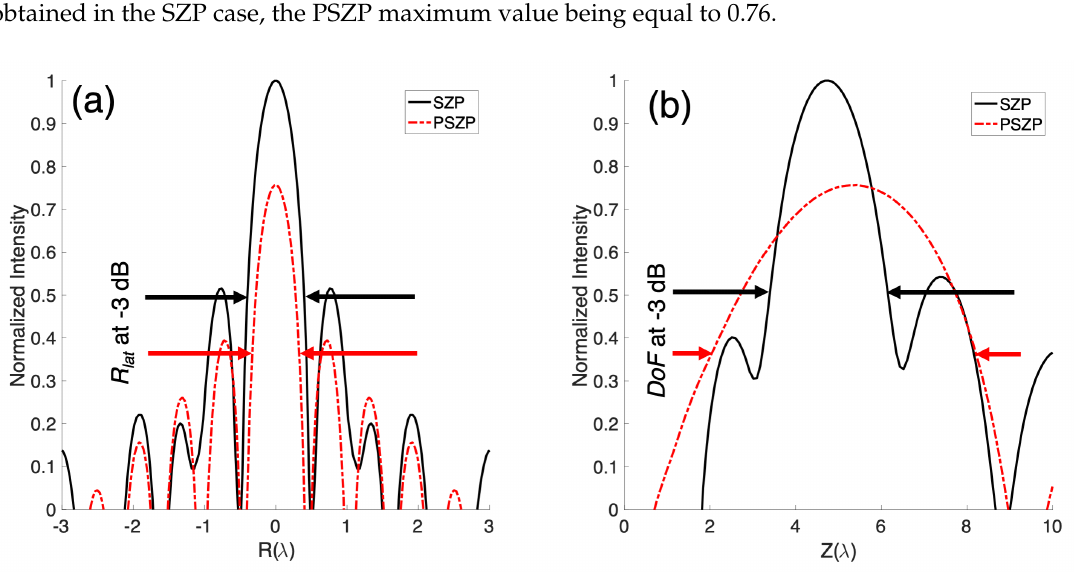
Figure 2. Numerical normalized intensity results for ( a ) the R -axis cut and ( b ) the Z -axis cut. The black solid line corresponds to classical Soret Zone Plate (SZP). The dashed-dotted red line corresponds to the amplitude pupil masked Soret Zone Plate (PSZP). Black and red arrows mark the DoF and R lat limits for SZP and PSZP, respectively.